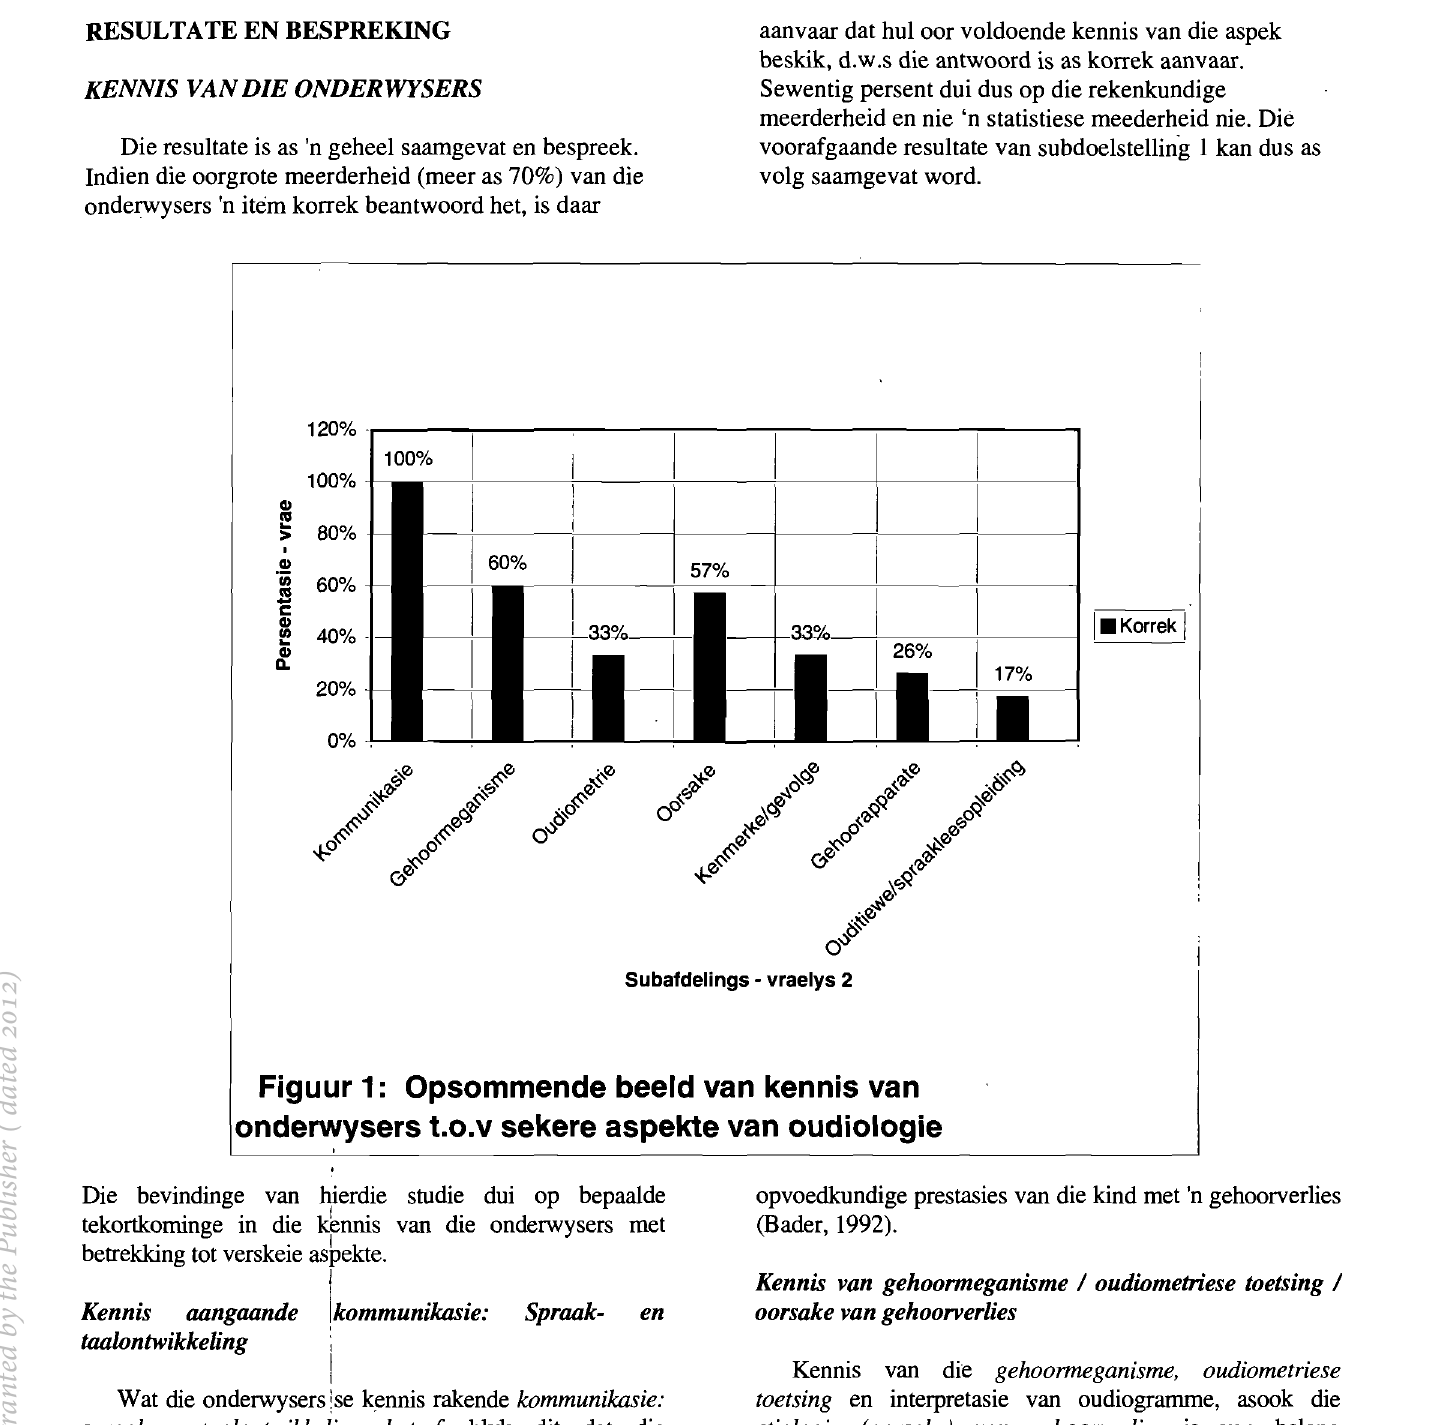
Figuur 1: Opsommende beeld van kennis